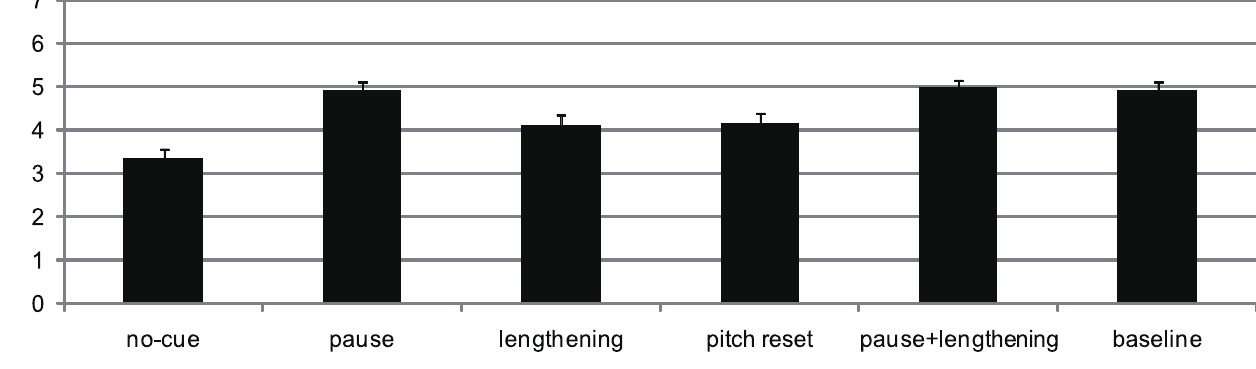
Figure 4. Perceived boundary strength across the six experimental conditions.